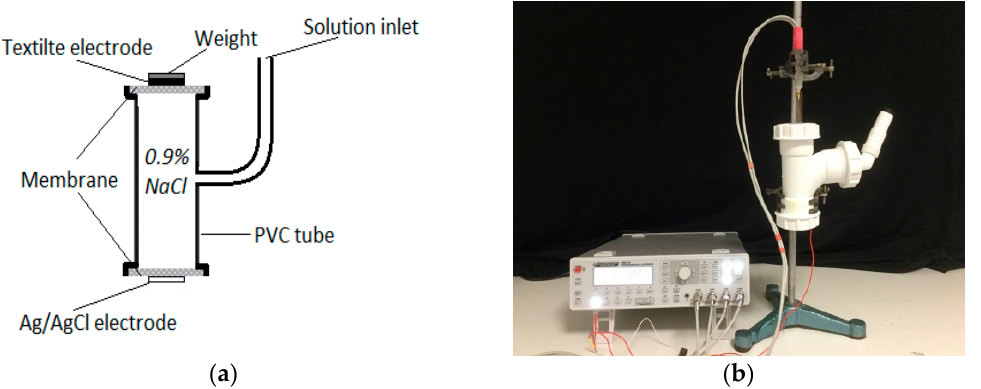
Figure 3. Skin-electrode impedance measurement on a skin dummy: ( a ) Skin dummy; ( b ) test setup.